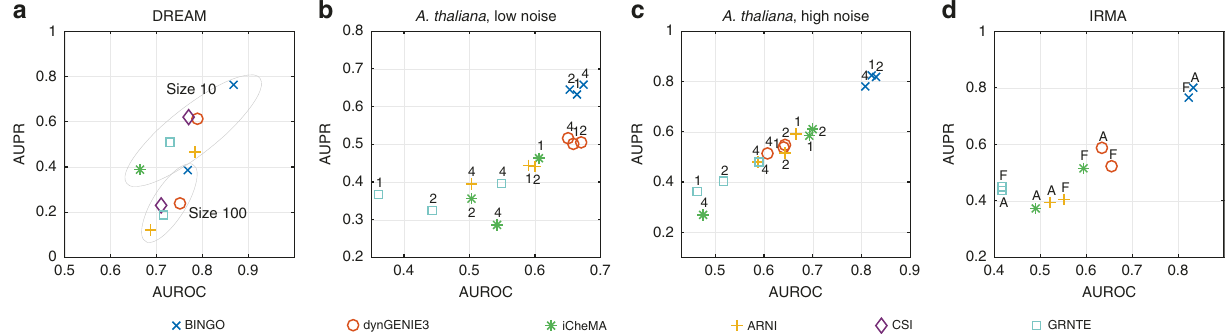
Fig. 2 Results on benchmark experiments. a The DREAM results consist of average values over the fi ve networks using the time series data only. b , c The results on the circadian clock of Arabidopsis thaliana consist of averages over ten replicates. The results for different sampling rates (1 h/2 h/4 h) are shown separately. d In the IRMA results, both full data (F) and averaged data (A) results are shown